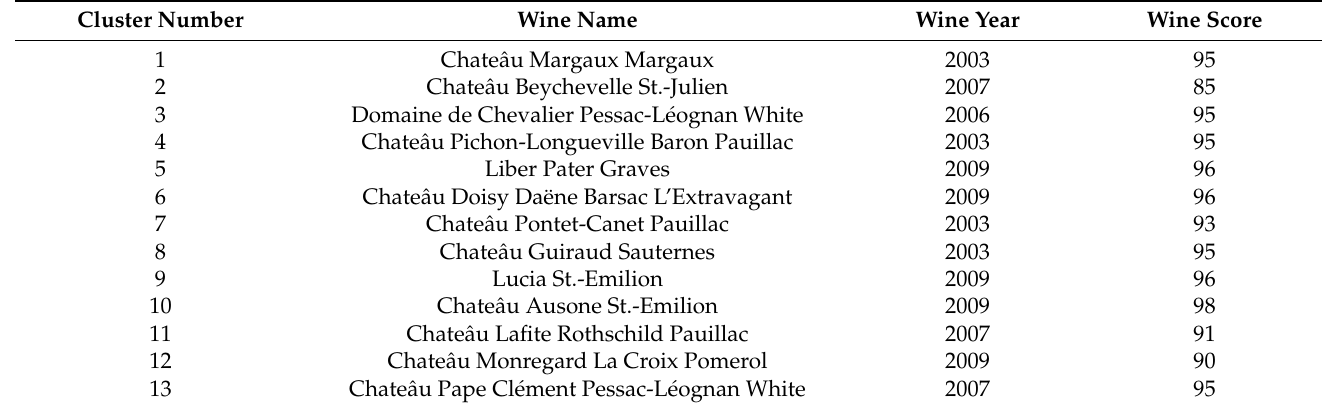
Table 3. Best representing wines with 13 Clusters. These wines are the best representation of their clusters, but they may not capture the overall similarity of the wines in their respective clusters as well as the representing wines with higher K values.